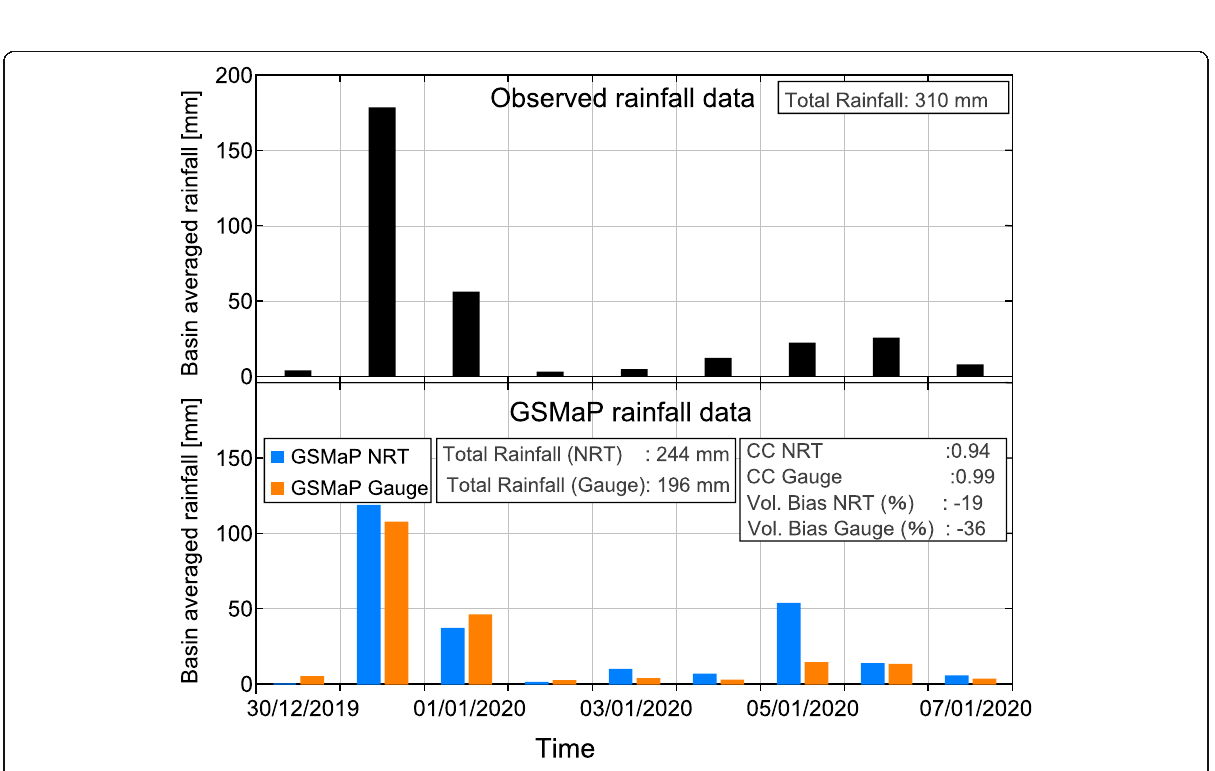
Fig. 5 Comparisons of daily rainfall between the GSMaP products (NRT & Gauge V7) and observation for flood event of